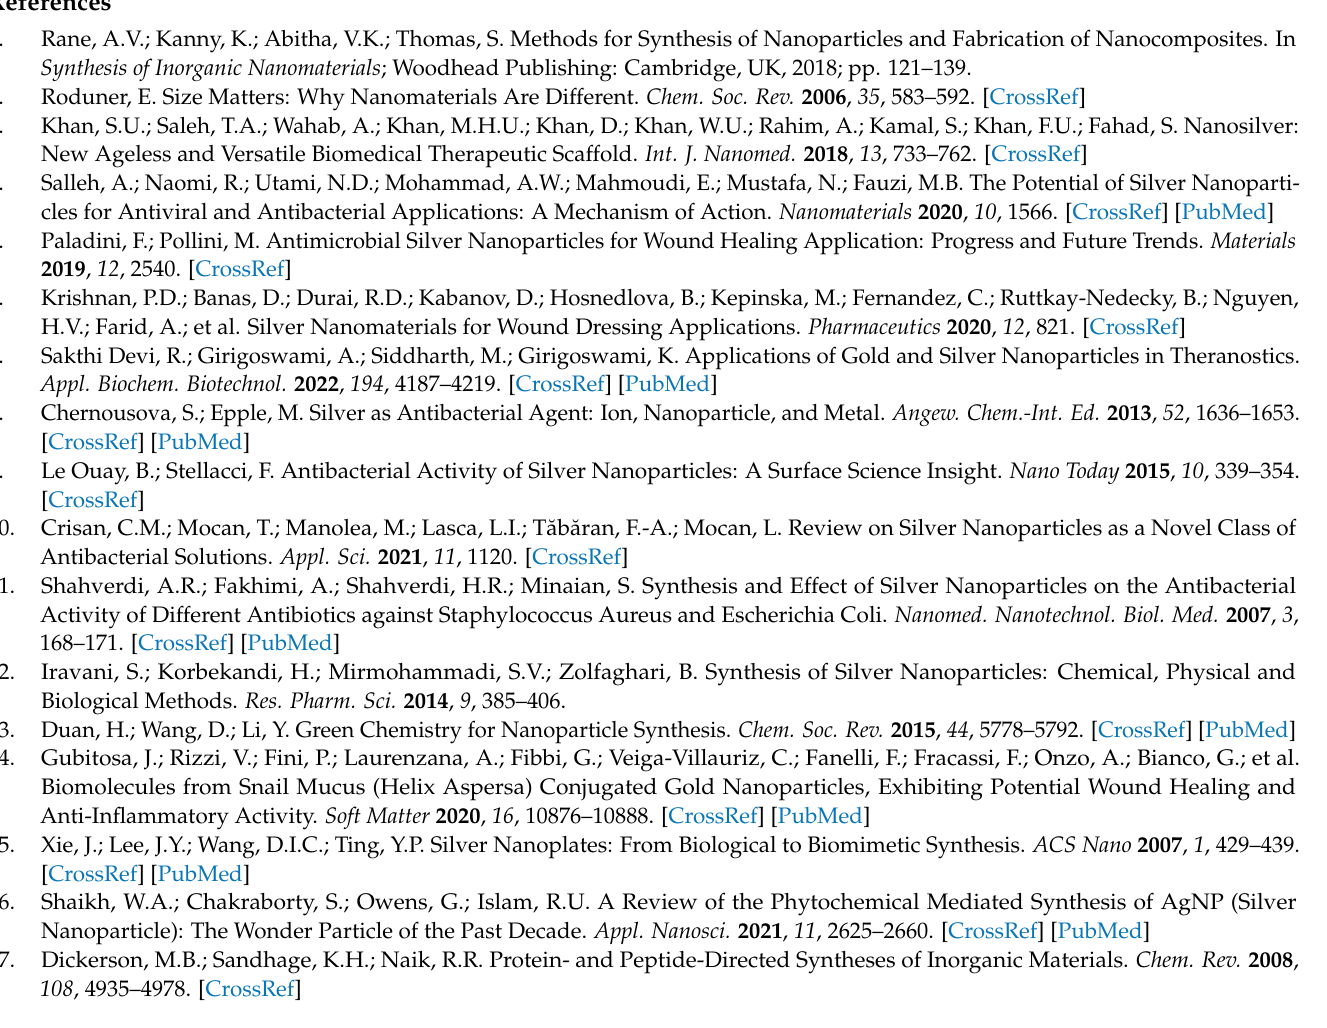
Figure S5: UV-vis spectra of AgNPs obtained from synthesis H collected after five days from the mixing of the reactants (blue line) and after fifty days (purple line).; Figure S6: Dose-response curves for samples G and H obtained for E. coli .; Table S1: One-way analysis of variance (ANOVA) of IC 50 values obtained for S. aureus and E. coli